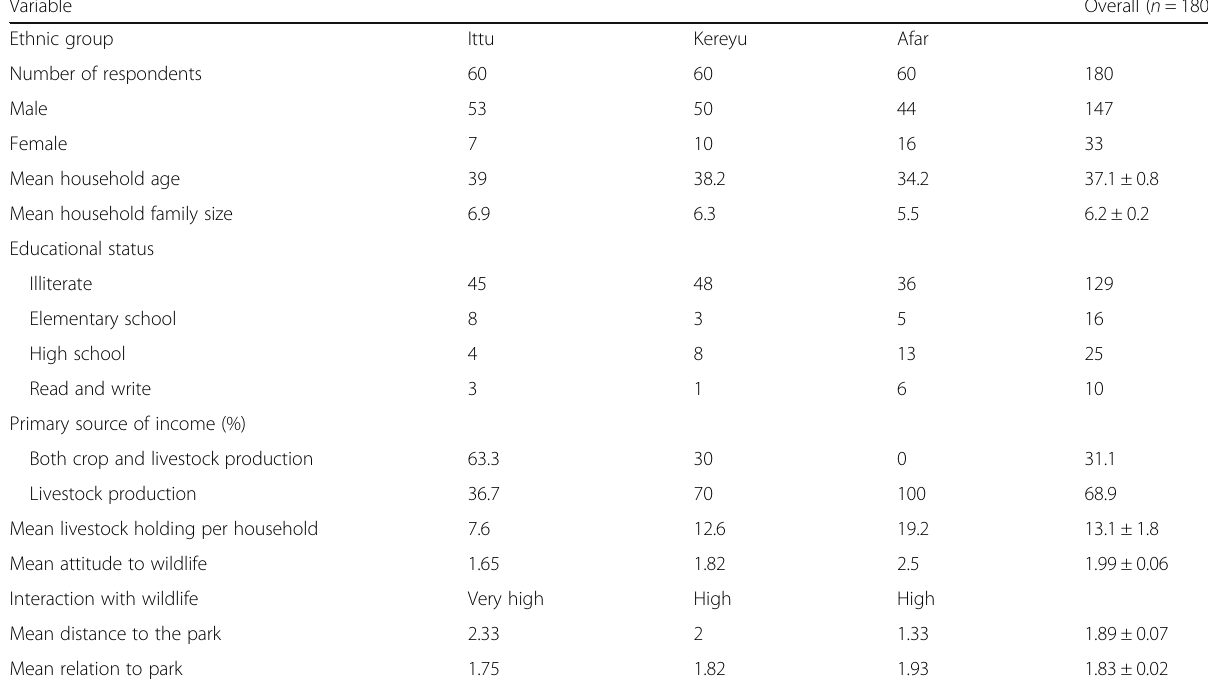
Table 2 Characteristics of respondent households, educational level, sources of income, and level of livestock-wildlife interaction around Awash National Park,